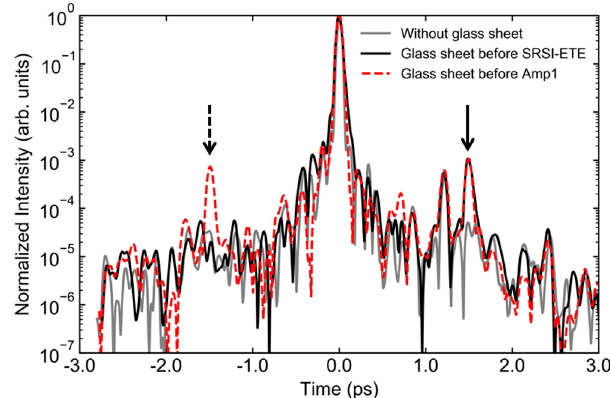
Figure 2. Measured temporal contrast without a glass sheet (gray line) and with a glass sheet before SRSI-ETE (black line) and before Amp1 (red dashed line). The solid and dotted arrows indicate the post- and pre-pulses with the glass sheet at + 1.47 and − 1.47 ps.